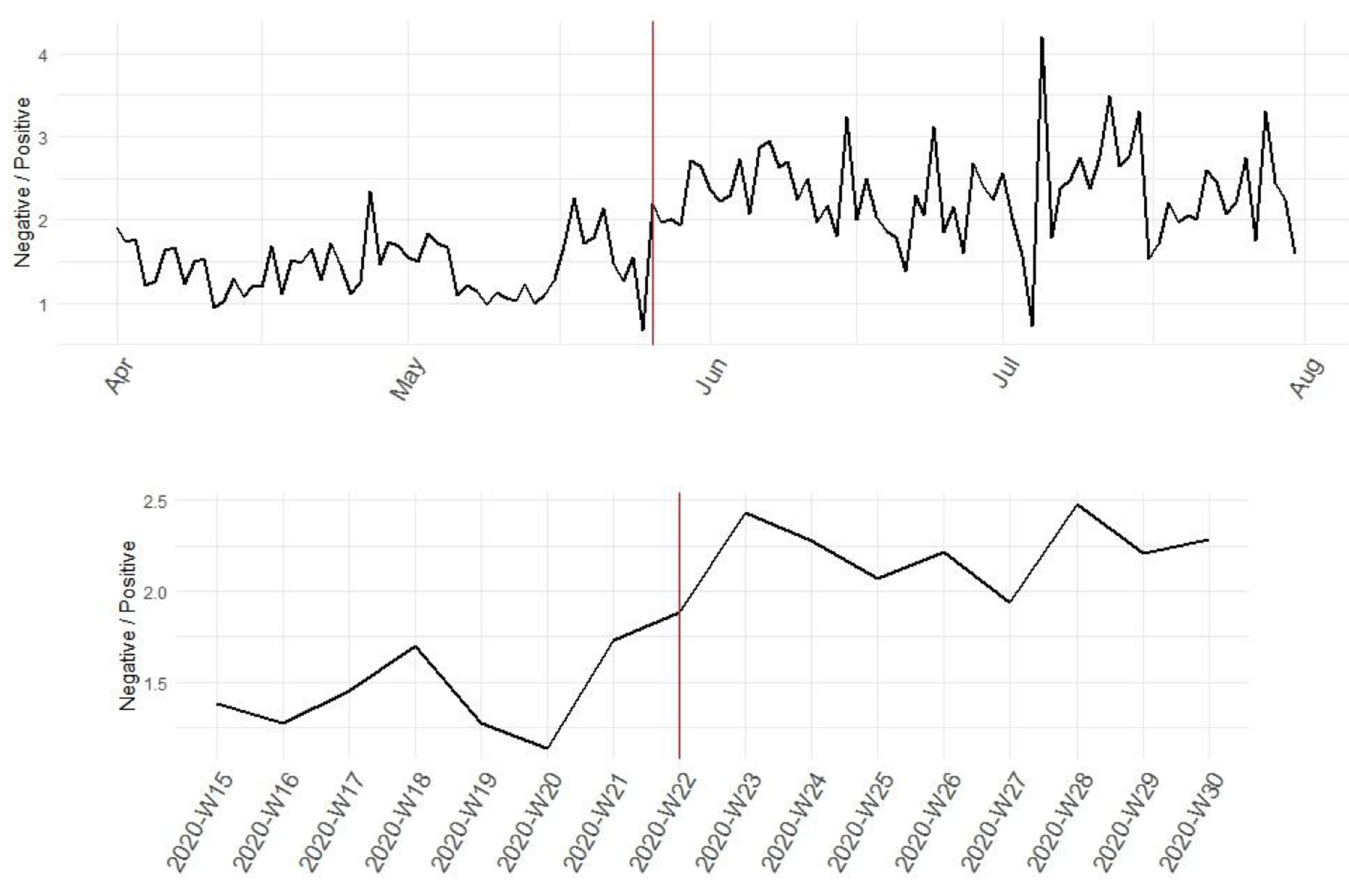
Fig 4. The negative-to-positive words ratio in the tweets of the 115 major police departments in the U.S. before and after the killing of George Floyd on May 25 th , 2020 (above: Daily information; bottom: Weekly information).